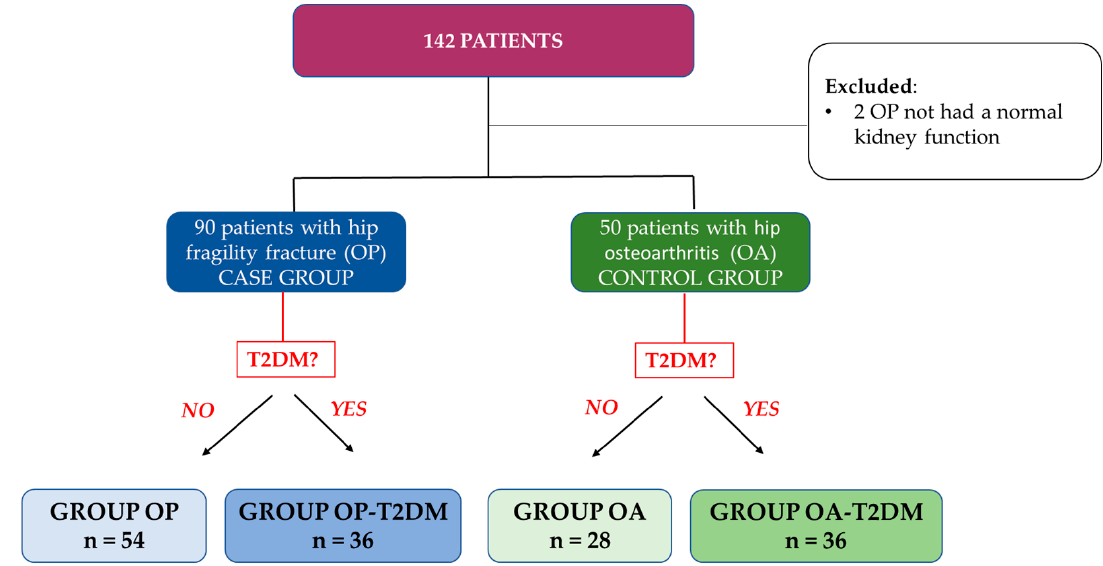
Figure 1. Outline of patient selection and study groups. OP, osteoporotic; OA, osteoarthritis; T2DM, type 2 diabetes mellitus.